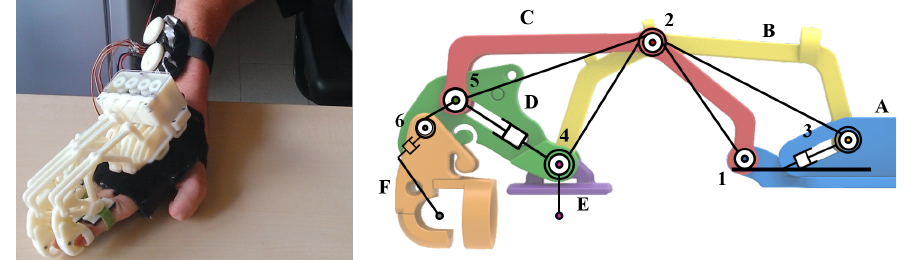
the patient and, on the right, the corresponding kinematic chain and Computer Aided Manufacturing (CAD) model. Colors and names (capital letters) of the components, and joints enumeration are reported as introduced in Section